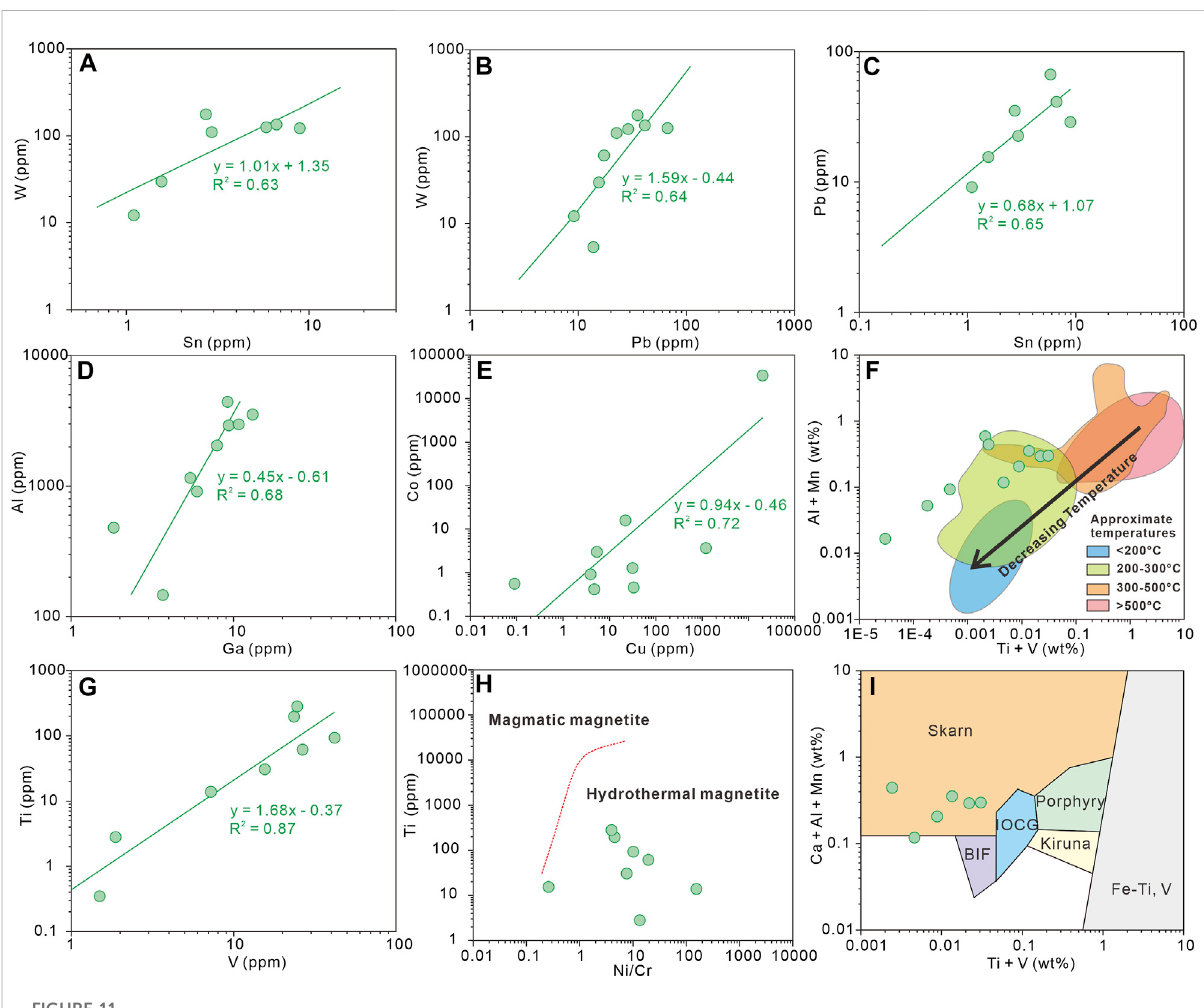
FIGURE 11 Correlation diagramsofvarioustraceelements(in ppm)inthestudiedmagnetite fromtheYi ’ nan TongjingAu – Cudeposit. (A) SnvsW; (B) Pbvs W; (C) SnvsPb; (D) GavsAl; (E) CuvsCo; (F) TheTi+VvsAl+Mnplotsdisplaysarecleardecreasingtemperaturetrend.Notethatthosetemperatures are estimates based on published values (Ahmad and Rose, 1980; Beane and Titley, 1981; Leach et al., 1988; Hayes, 1990; Landis and Hofstra, 1991; DoughtyandChamberlain,1996;ManskeandPaul,2002;AudetatandPettke,2006;Thorneetal.,2008;Sillitoe,2010;Nadolletal.,2012); (G) V vs Ti; (H) Ni/Cr vs Ti; (I) Ti + V vs Ca + Al + Mn (Dupuis and Beaudoin, 2011). Abbreviations: BIF – Banded iron formation, IOCG – Iron oxide-copper- gold deposits, PCDs – Porphyry Cu deposits, Kiruna – Kiruna apatite – magnetite deposits, Fe – Ti, V – Magmatic Fe – Ti – oxide